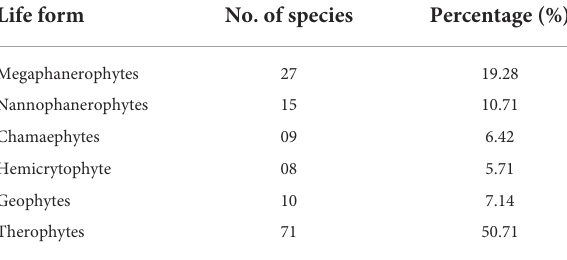
TABLE 2 Life form spectra of the Bin Dara vegetation.